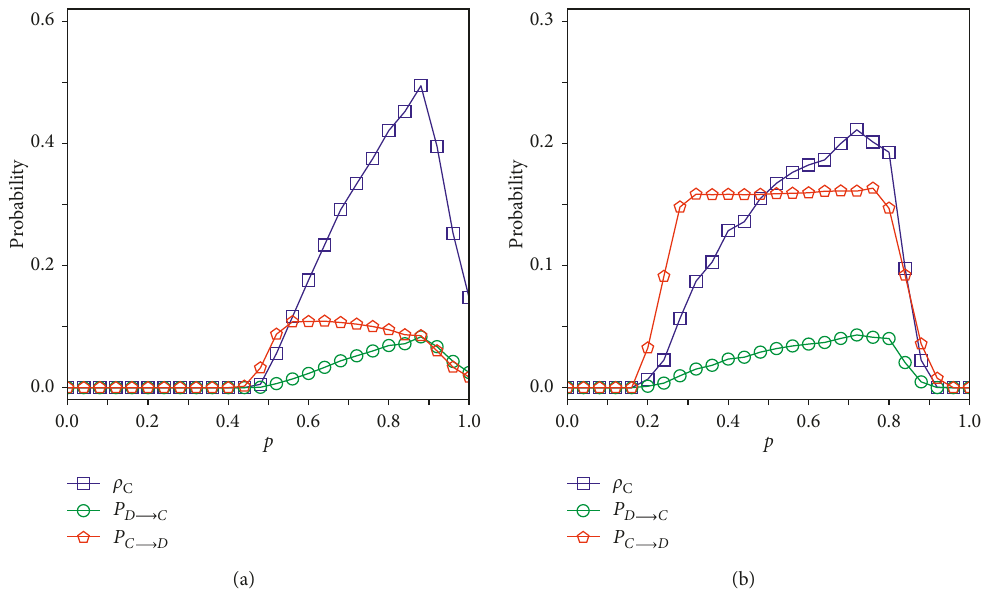
Figure 3: The cooperation level ρ players into C players for regular square lattice, and WS small-world network,